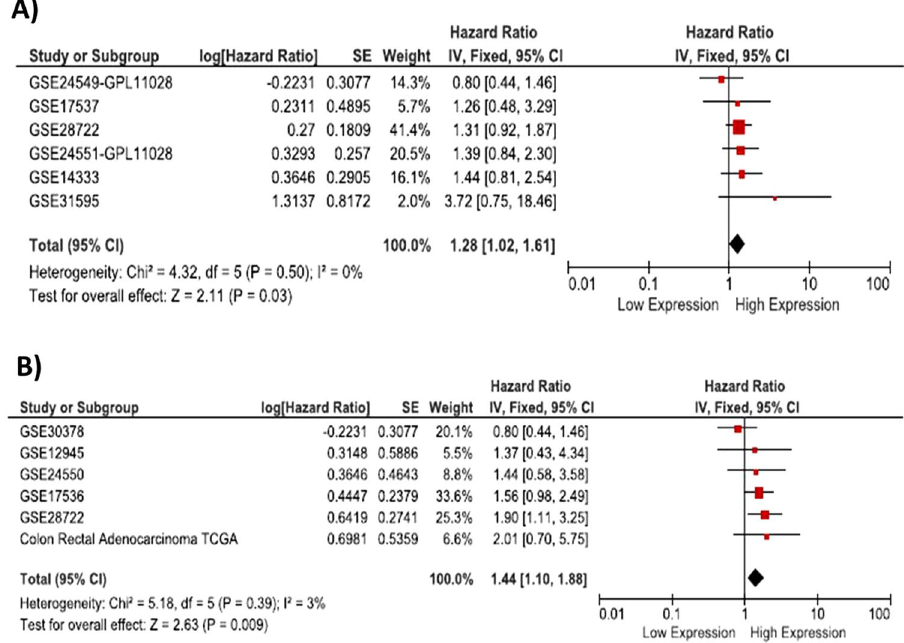
Figure 6. Meta-analysis of colon cancer datasets contained in SurvExpress. ( A ) A DDIt4 overexpression increases the risk of recurrence by 28% (P = 0.03) ( B ) and the risk of death by 44% (P =